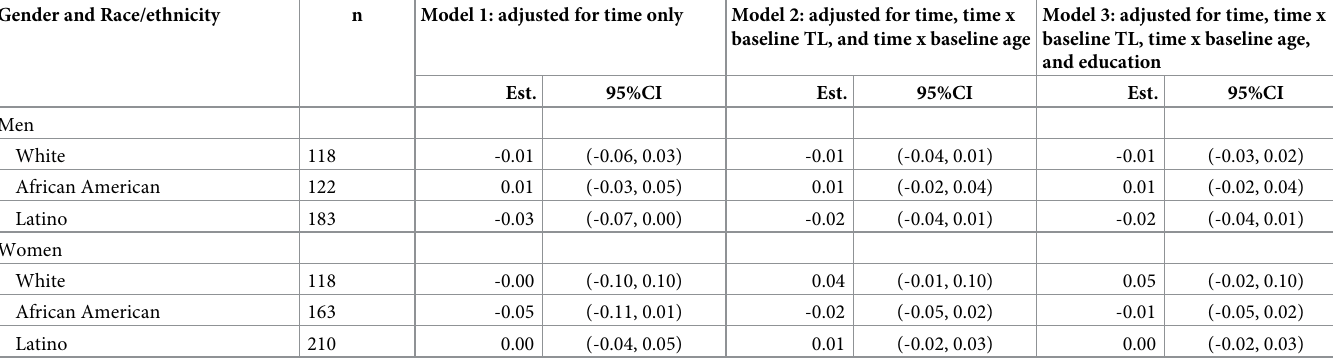
Table 3. Estimated change in 10-year telomere attrition associated with 1-SD increase in hazardous working conditions by gender and